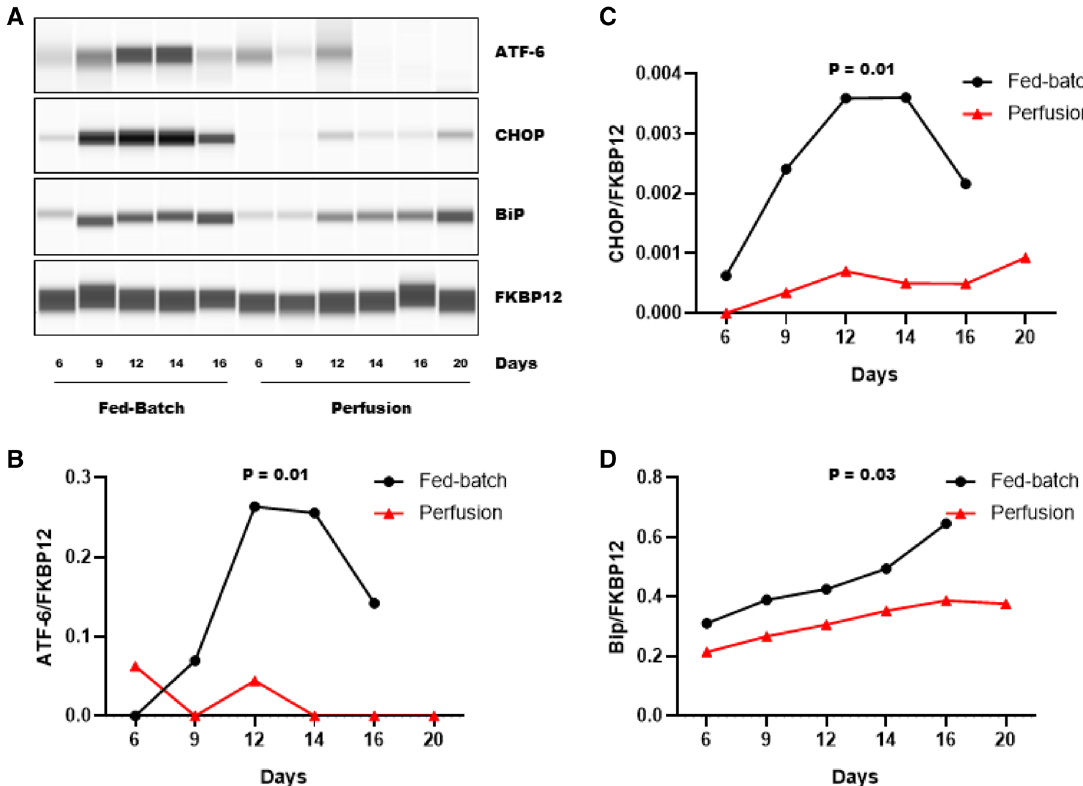
Figure 6. Analysis of ER stress in fed-batch and perfusion processes. Cell pellets were collected on the indicated days from a fed-batch and a perfusion bioreactor to determine protein expression of ATF-6, CHO and BiP using capillary western blot analysis. FKBP12 was used as a loading control. ( A ) Representative western blot images for ATF-6 (~ 100 kDa), CHOP (~ 27 kDa), BiP (~ 70 kDa) and FKBP12 (~ 12 kDa) are shown. ( B – D ) Densitometric analysis of western blot. Data are expressed as target protein AUC/loading control